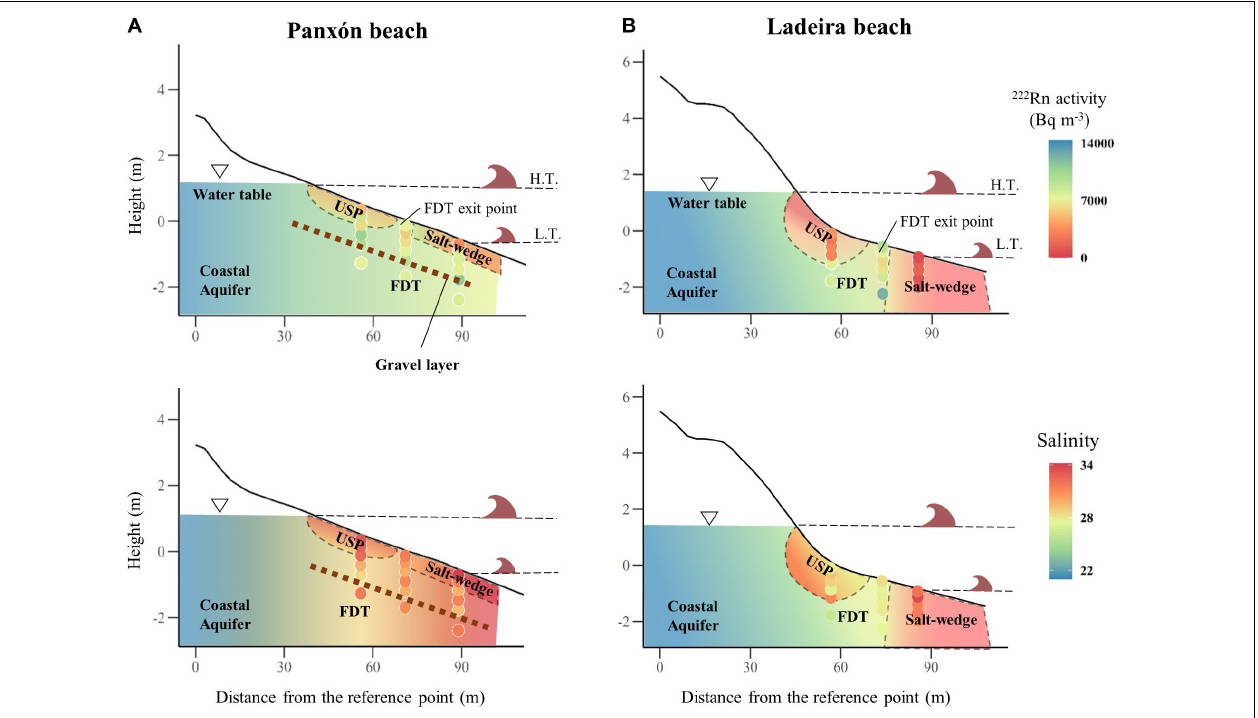
FIGURE 8 | (A) Schematic representation of porewater circulation in Panxón beach, using porewater 222 Rn and salinity profiles measured in October. (B) Schematic representation of porewater circulation in Ladeira beach, using porewater 222 Rn and salinity profiles from May. HT, High Tide; LT, Low Tide; USP, Upper Saline Plume; FDT, Fresh groundwater Discharge